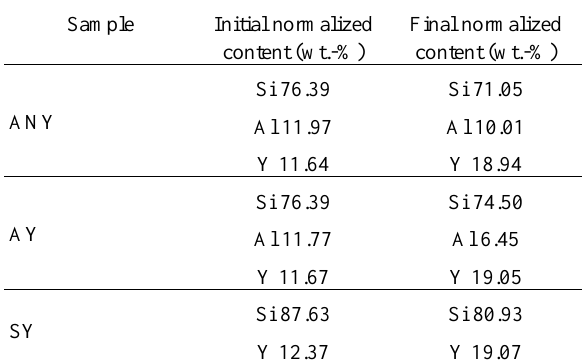
Table 3. Relative content of Si, Al and Y in the starting powders (calculated) and after sintering at 2100 °C (determined by EDS analysis). Sample